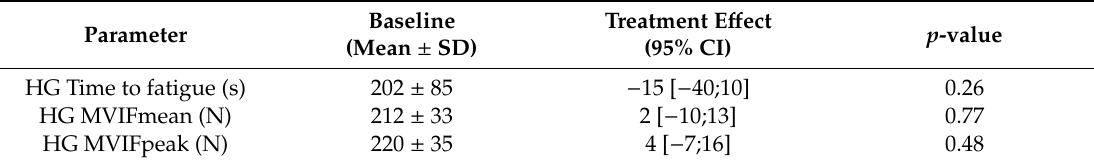
Table 3. Handgrip force and handgrip time to fatigue baseline measures and treatment e ff ects after eating a ketogenic LCHF diet for 24–26 days 1 .